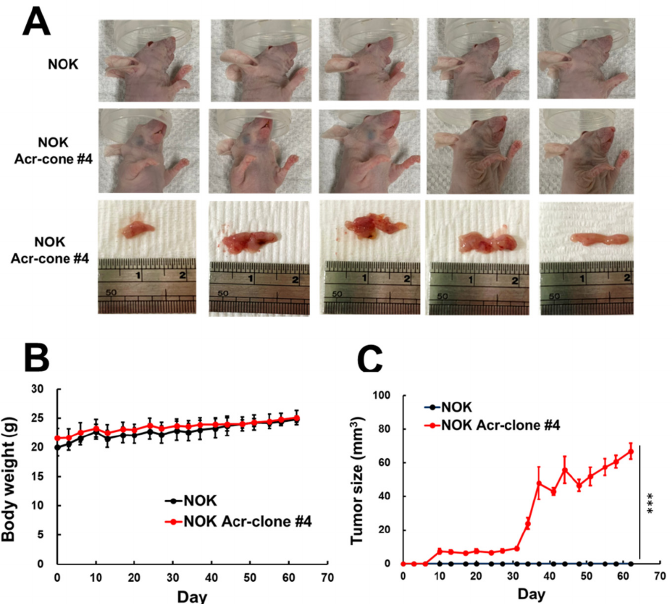
Figure 2. Xenograft mice model of acrolein-transformed clones. ( A ) Overall view of tumors formed by acrolein-transformed NOK cell clone (NOK Acr-clone #4). Tumors in nude mice were seen after injection with acrolein-transformed clone #4, whereas none were seen after orthotopic injection with normal human oral keratinocytes (NOK). ( B ) Tumor growth curves and ( C ) body weight for nude mice of different experimental groups ( n = 5). Student’s t -tests were used to determine statistical significance, and two-tailed p -values are shown. *** p < 0.005 compared with NOK parental cells.